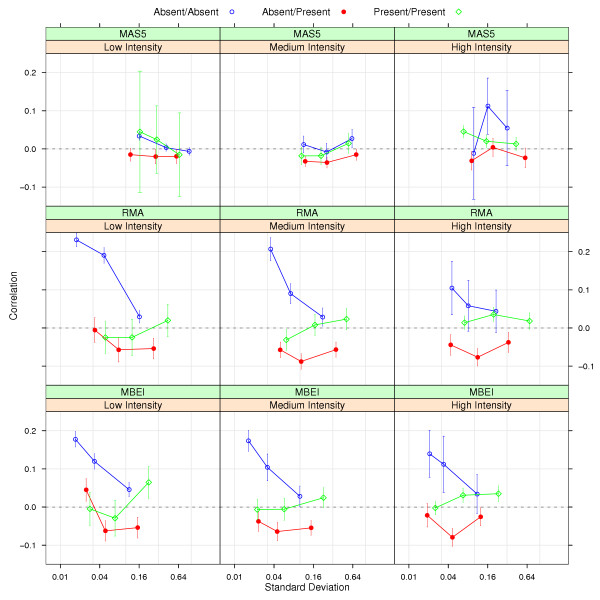
Correlations of the randomly sampled pairs of genes by percentage of present calls and mean intensity. The summary curves show the average correlation of the pairs of genes sampled from the breast cancer data. The differently colored curves correspond to the groups of absent/absent, absent/present and present/present pairs that have been defined in the text and are shown in Figure 6. Additionally, the pairs of genes have been arranged by their average mean intensity across chips: the range of average intensities was split into three intervals with an equal number of pairs, from the lowest third on the left to the highest third on the right. Grouping the pairs by their absence/presence status yields distinctly different patterns of correlations for RMA and MBEI, these patterns are however highly consistent between the intensities.